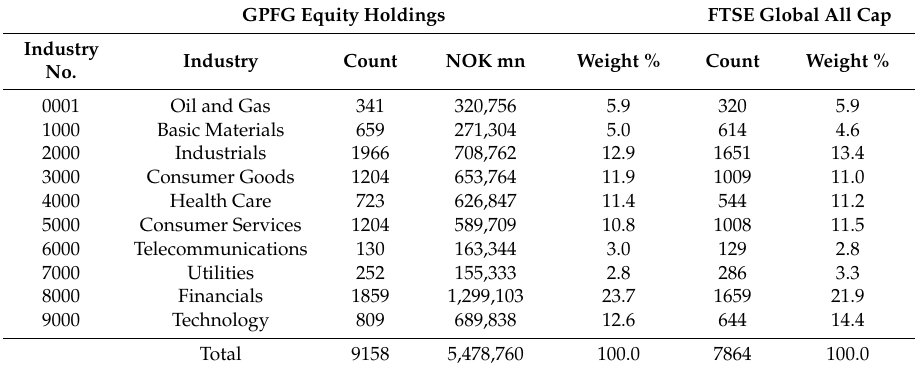
Table 1. The company count and industry weights for companies in each Industry Classification Benchmark (ICB) industry in the Government Pension Fund Global (GPFG) and FTSE Global All Cap Index (GEISAC), as well as their market value in the GPFG, as of Dec. 31, 2018. Sources: Norges Bank Investment Management (2017b) and FTSE Russell